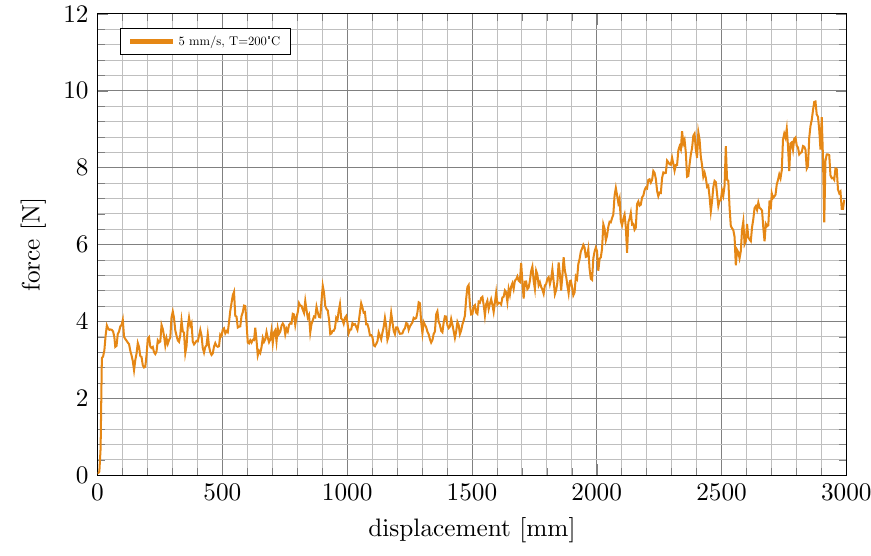
Figure 13. Deforming forces of GF-PP at 200°C and D fe =